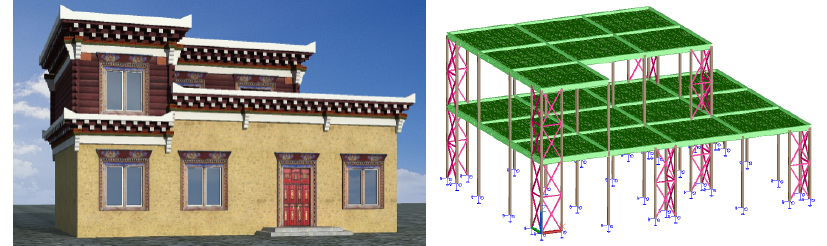
Figure 1. Architectural drawing and structural layout.